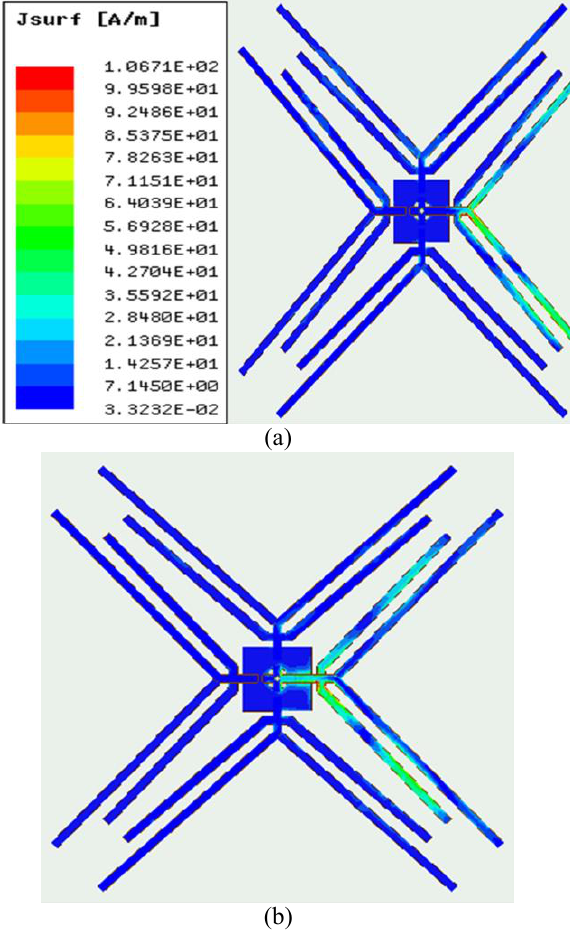
Figure 5: Simulated current distribution for case 1 (a) f 1